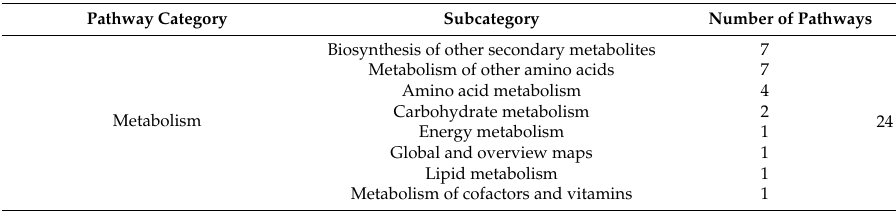
Table 2. Categories and subcategory of KEGG